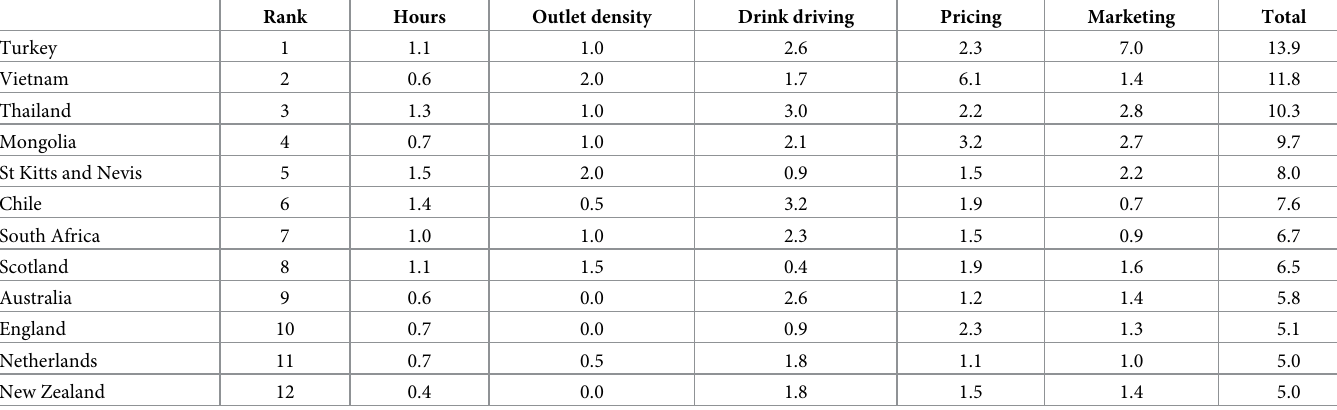
Table 2. Countries ranked by IAC Policy Index and domain scores; higher scores indicate more restrictive policy). Rank